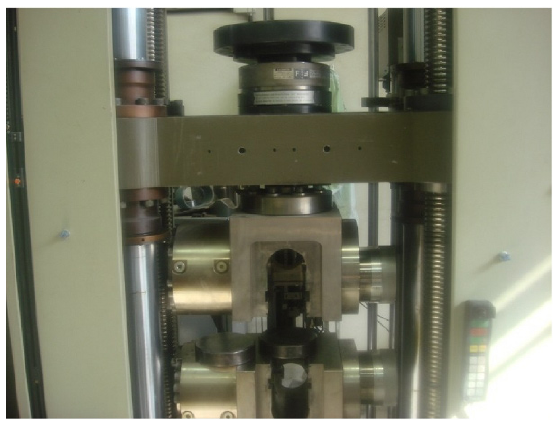
Figure 4. ZWICK testing machine for quasi-static